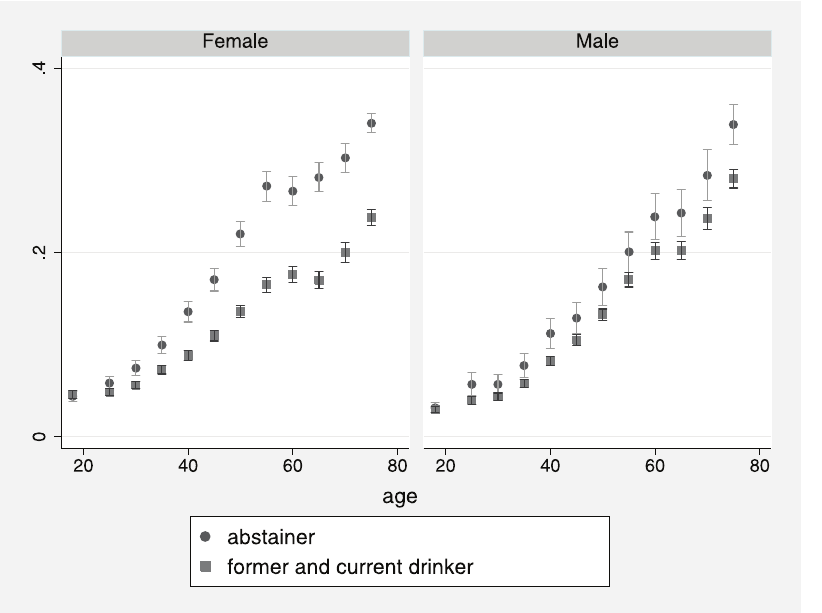
Figure 3. Prevalence of fair/ poor health byage, gender and drinking status: Abstainers vs. formerand current drinkers combined (spike with caps: 95% confidenceinterval).